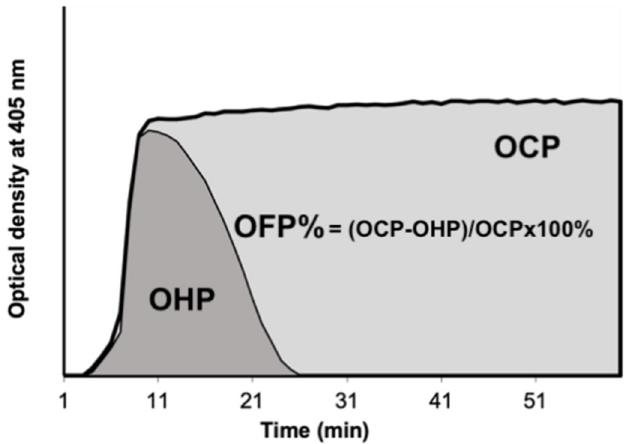
Figure 1. Overall Hemostatic Potential (OHP) assay. The area under the fibrin aggregation curve obtained by the addition of thrombin (0.006 IU/mL) and CaCl 2 to platelet-poor plasma is the OCP. The area under the fibrin aggregation curve obtained by adding thrombin (0.006 IU/mL), CaCl 2 and tPA (600 ng/mL) to plasma is the OHP. The OFP% is the difference between the OCP and OHP, expressed as a percentage. Abbreviations: OCP overall coagulation potential; OHP overall hemostatic potential; OFP% overall fibrinolytic potential.